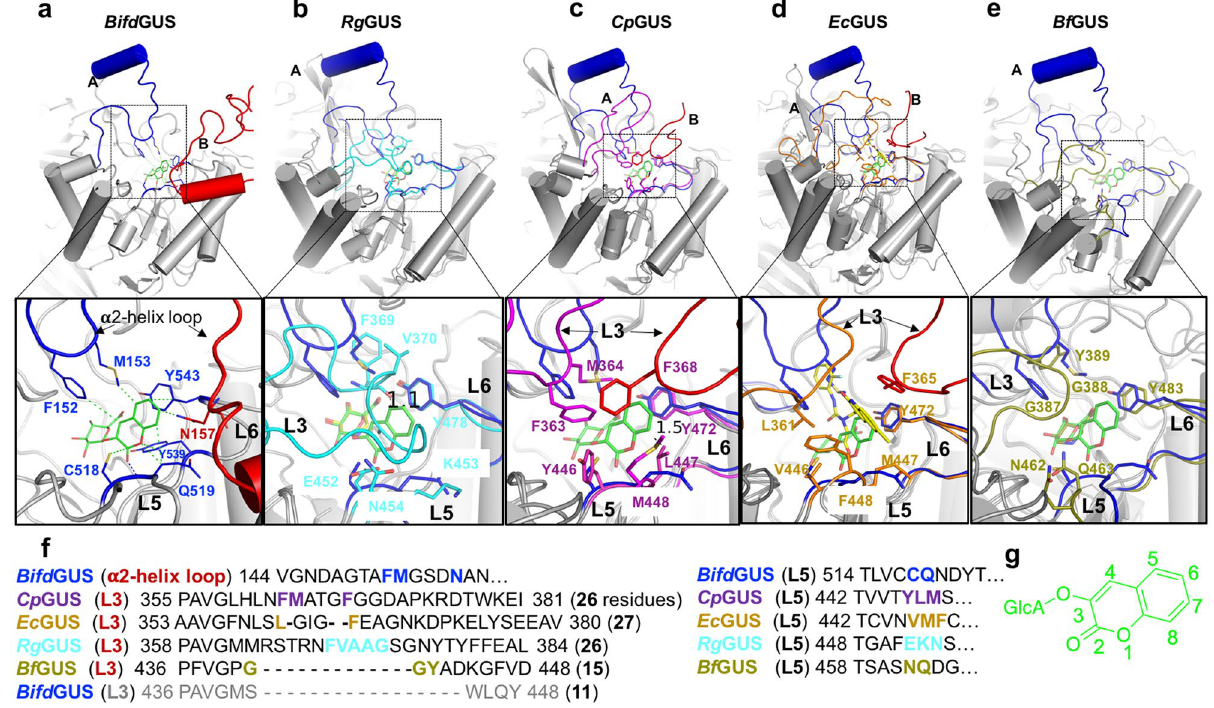
Figure 4. Loop 3 (or the α 2-helix loop) and loop 5 are important for the substrate preferences of the GUSs. Comparison of the ABSs of the five bacterial GUSs. The structures of Rg GUS/UIFG ( b ), 4JKM ( Cp GUS-apo) ( c ), 3LPG (the Ec GUS/N-substituted-thiourea derivative) ( d ), and Bf GUS/UIFG ( e ) were superimposed on the structure of Bifd GUS E479A / 10 ( a ). The substrate-binding sites of GUSs are located at the center of the TIM barrel domains. Panels ( a – e) display the ABSs that are formed by the conserved loop 6 (L6) and variable loop 5 (L5) and loop 3 (L3) or α 2-helix loop. The α 2-helix loop in Bifd GUS occupies a position similar to that of loop 3 in the other GUSs. ( f ) Sequences of loop 3 (or the α 2-helix loop) and loop 5 in the five bacterial GUSs. Residues interacting with the aglycone of 10 are shown as blue, cyan, magenta, yellow, and olive sticks in panels a – e , respectively. ( g ) Molecular structure of 10